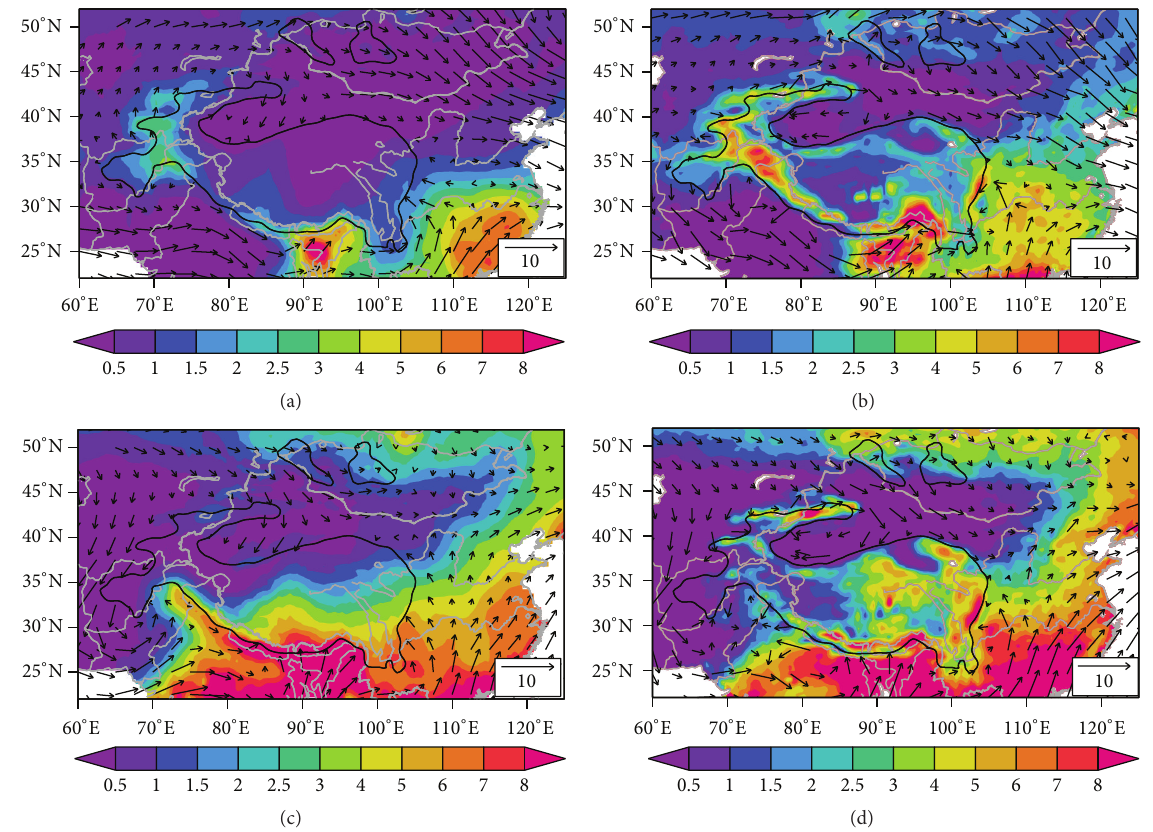
Figure 3: Observed (a, c) and simulated (b, d) mean precipitation rate (units: mm day −1 ) and 850 hPa wind (units: ms −1 ) in spring (a, b) and summer (c, d). The black lines are the terrain contours of 2000 m.